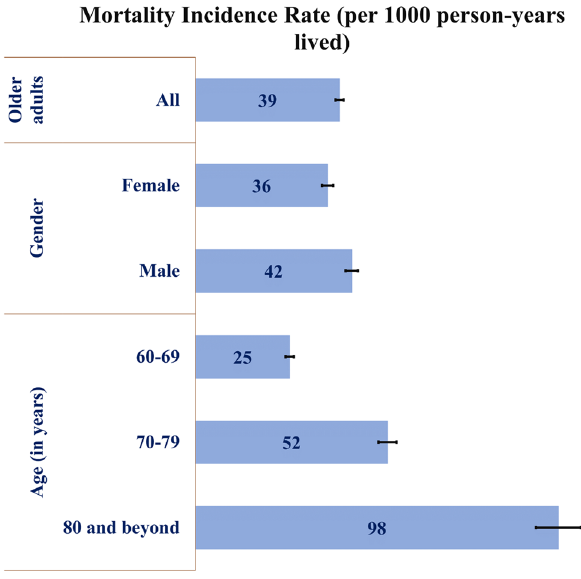
Figure 1. Incidence rate of mortality (deaths per 1000 person years lived) among older adults for the period from 2005 to